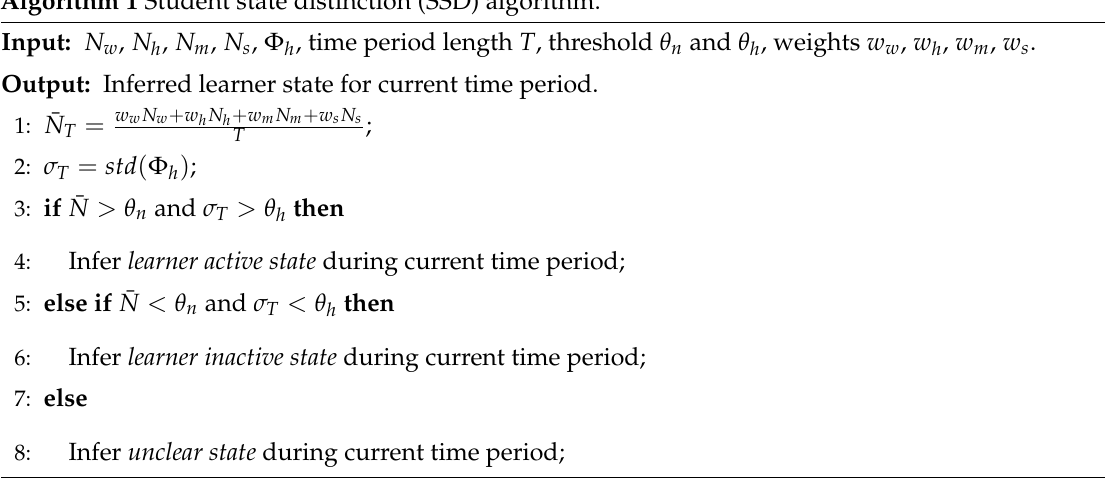
Algorithm 1 Student state distinction (SSD)